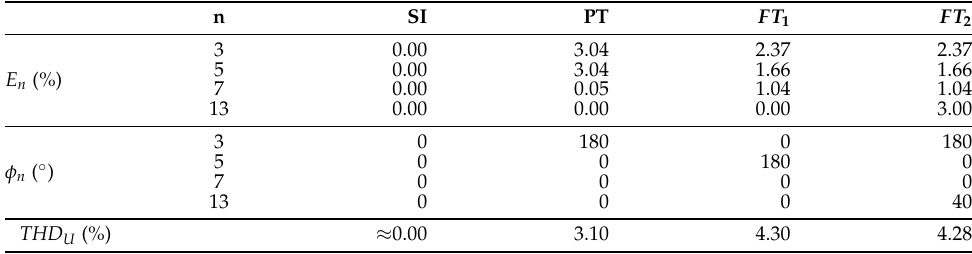
Table 4. Characteristics of the voltage